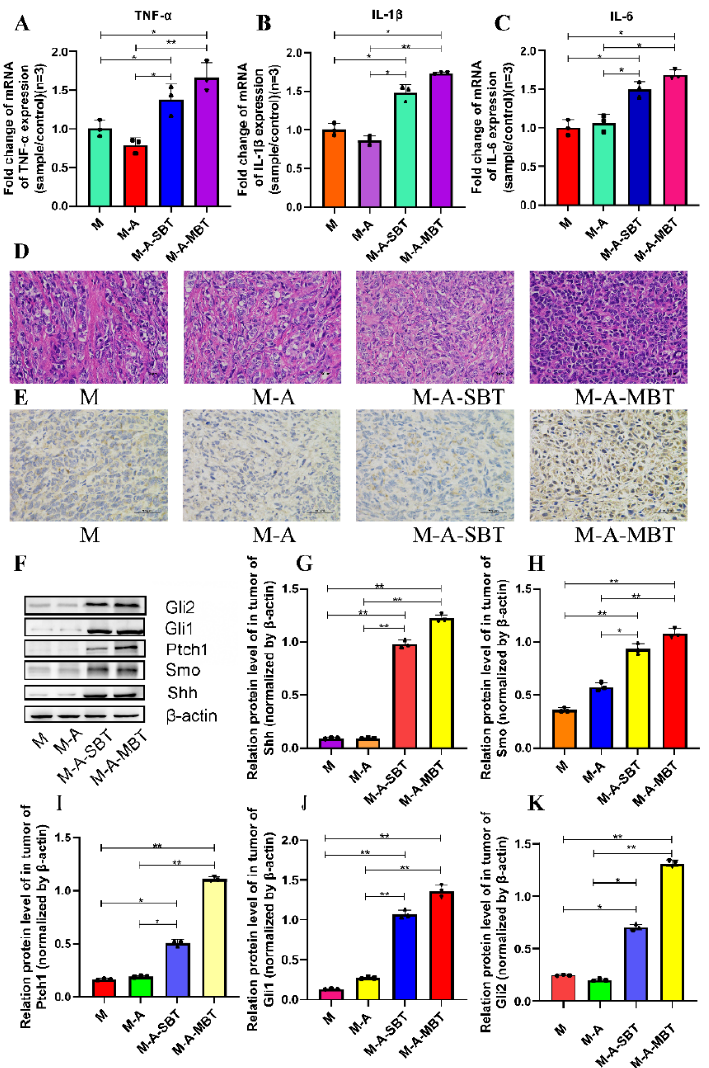
Figure 5. P. acnes promotes tumour growth by increasing the inflammatory response to activate the Hh signalling pathway. Proinflammatory cytokines ( A ) TNF- α , ( B ) IL-1 β , and ( C ) IL-6 were detected in tumour tissues at the gene level by q-PCR. ( D ) H&E staining images of tumour tissues were presented; the bar represents 50 µ m. ( E ) Immunohistochemistry of Gli1 expression was determined in EOC of mice; bar represents 50 µ m. ( F ) Western blot analysis of Shh, Smo, Ptch1, Gli1, and Gli2 expression in tumour tissues; β -actin was used as an internal control ( n = 3). The relative expressions of ( G ) Shh, ( H ) Smo, ( I ) Ptch1, ( J ) Gli1, and ( K ) Gli2 were quantified by Image J. Three mice were randomly selected in each group. Data are presented as means ± SD. One-way repeated measures ANOVA with Tukey’s test for multiple comparisons; * p < 0.05, ** p < 0.01.